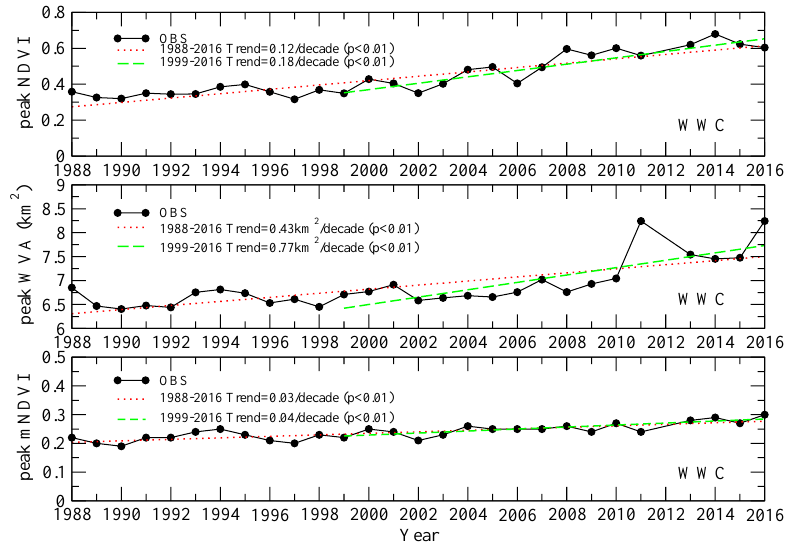
Figure 12. The time series plots and trends of peak NDVI at the WWC’s typical wetland vegetation pixel ( top ), peak wetland vegetated area ( center ), and the peak spatial mean NDVI (bottom) in the WWC.